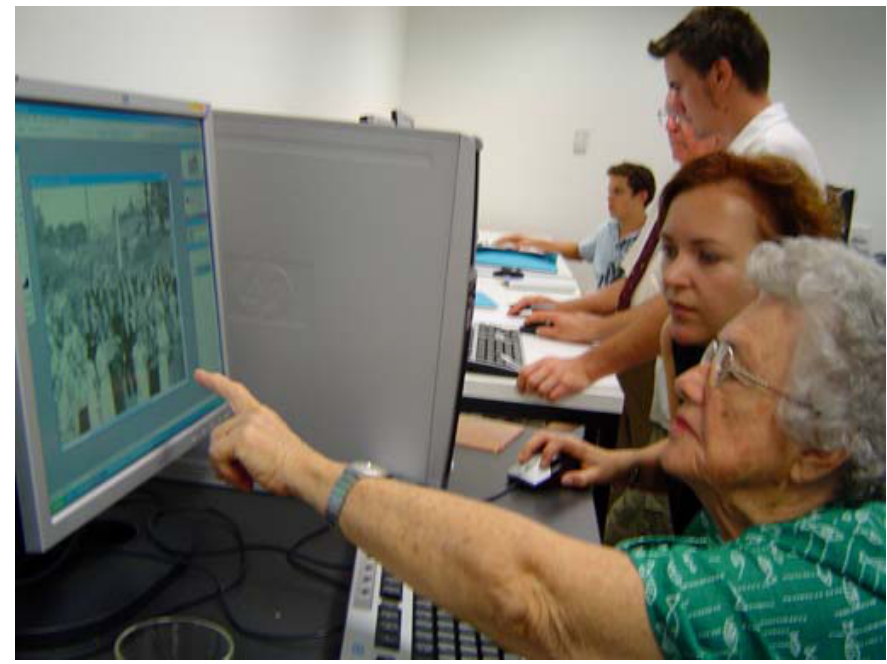
Figure 13: KGUV Sharing Stories Workshop